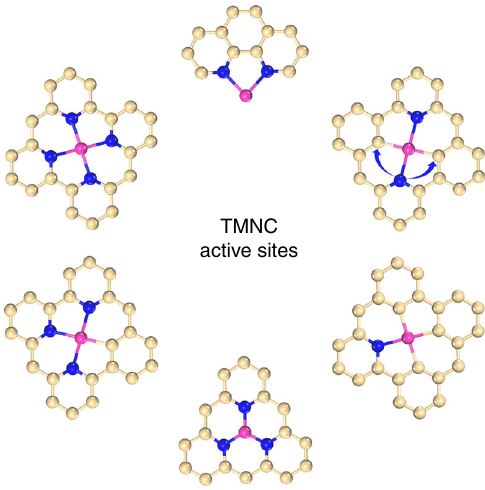
Fig. 1 Schematic illustration of active site structures in transition metal – nitrogen – carbon system. Light yellow, blue and pink ivory balls represent carbon, nitrogen and transition metal atoms,